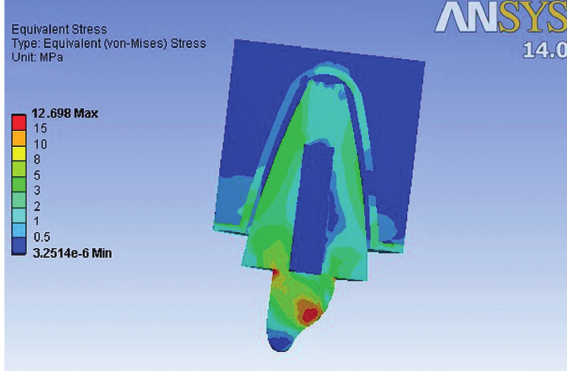
Figure 4: Areas of stress concentration in Model 1 on oblique loading.